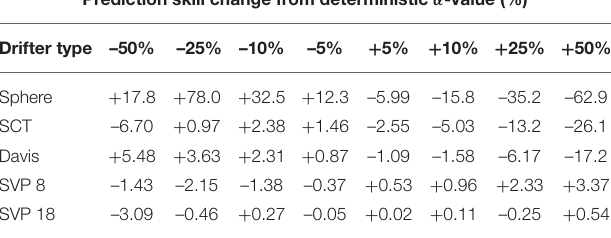
is expected to deflect the surface current further to the right of TABLE 2 | Percent change in mean trajectory prediction skill for given adjustments to deterministic wind drag factor, α . Prediction skill change from deterministic α -value